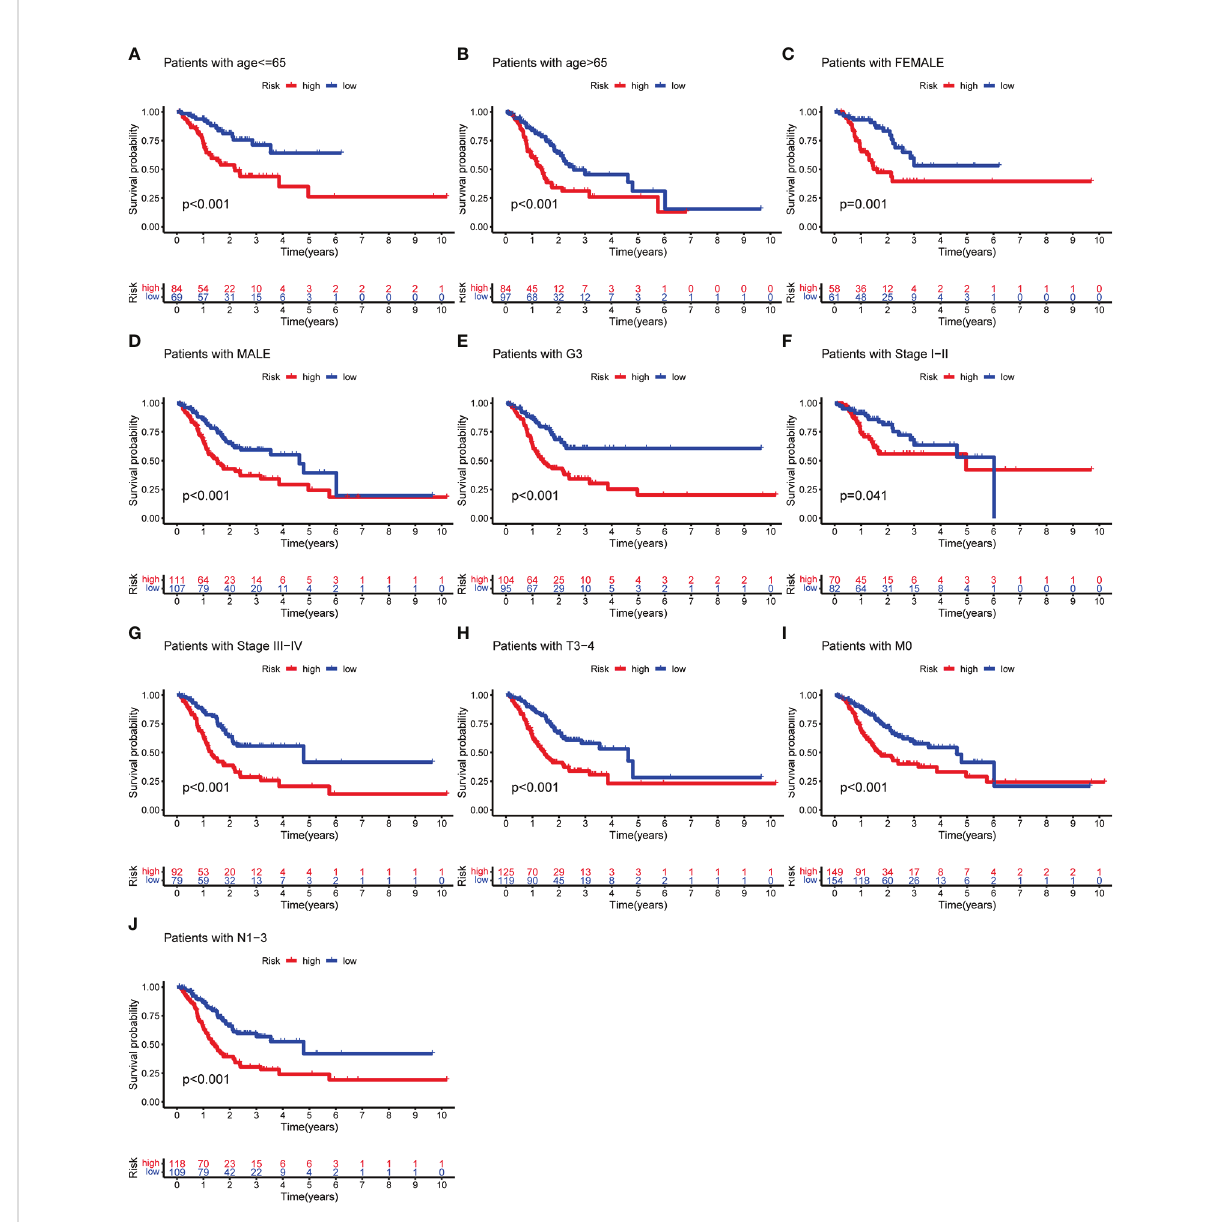
FIGURE 10 KM analysis with different clinicopathological features in different risk subgroups. (A) Age ≤ 65. (B) Age > 65. (C) Female. (D) Male. (E) G3. (F) Stage I-II. (G) Stage III-IV. (H) Stage T3-4. (I) Stage M0. (J) Stage